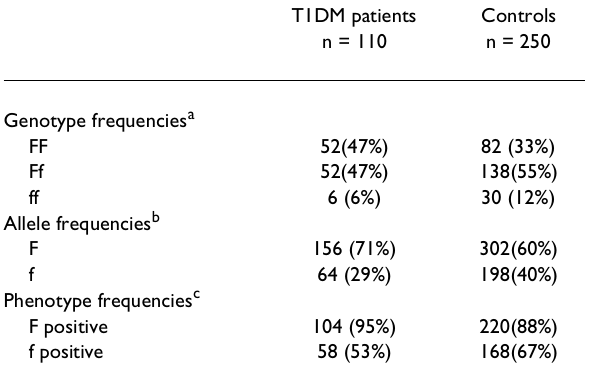
Table 1: VDR- Fok I polymorphism in study subjects